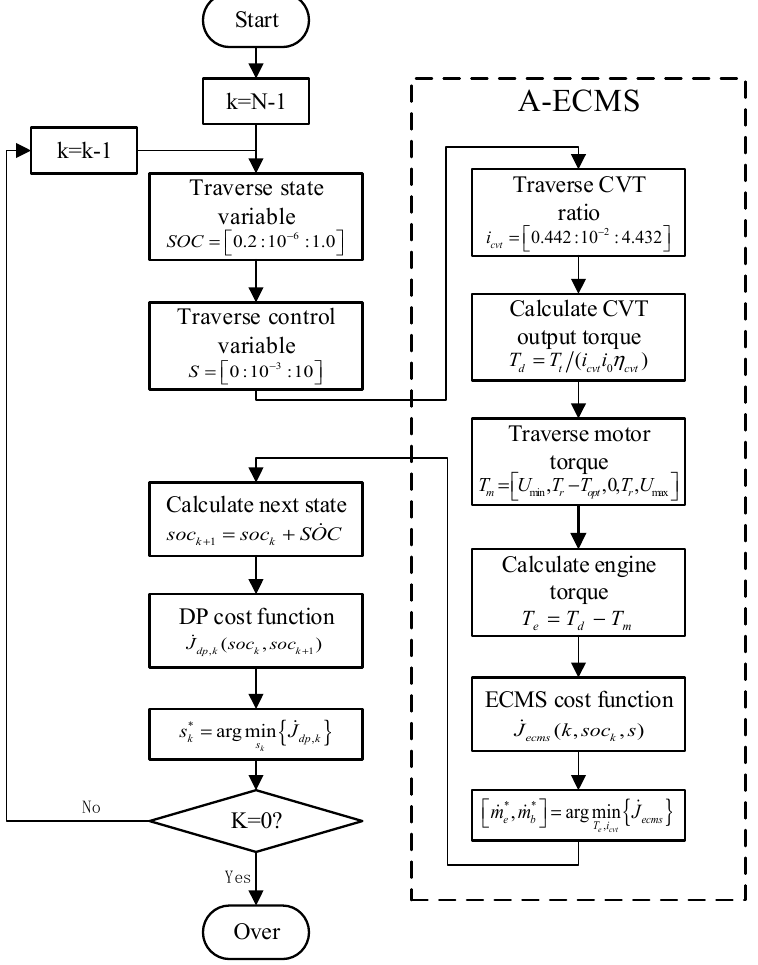
Figure 4. Flowchart of the improved dynamic programming algorithm.